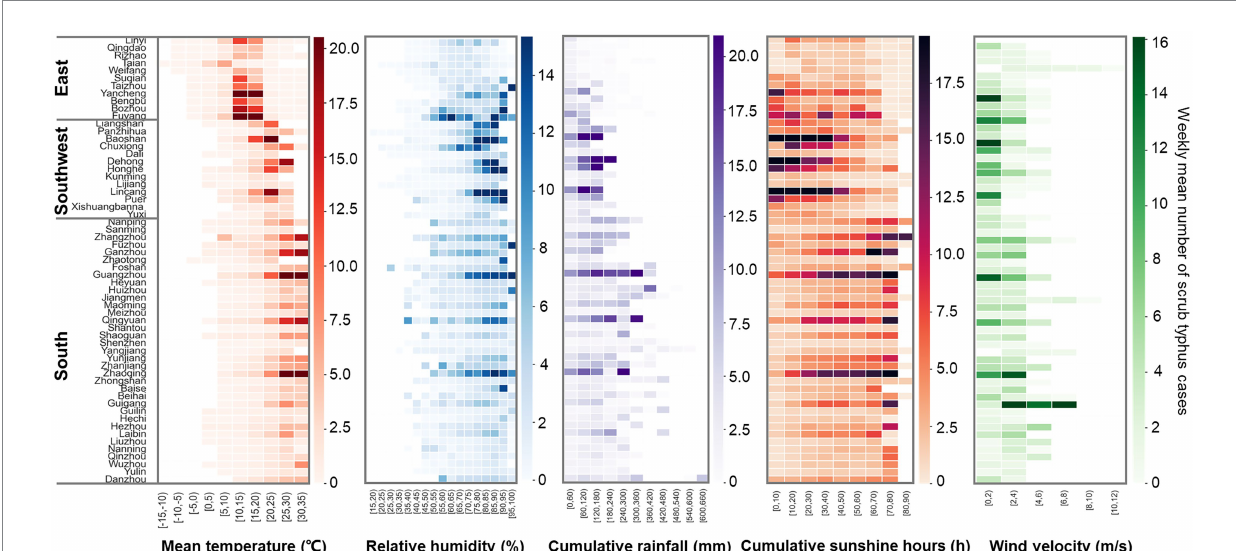
FIGURE 2 Heatmaps of scrub typhus cases against meteorological factors. Each cells denotes the weekly mean scrub typhus cases under the corresponding climate conditions.